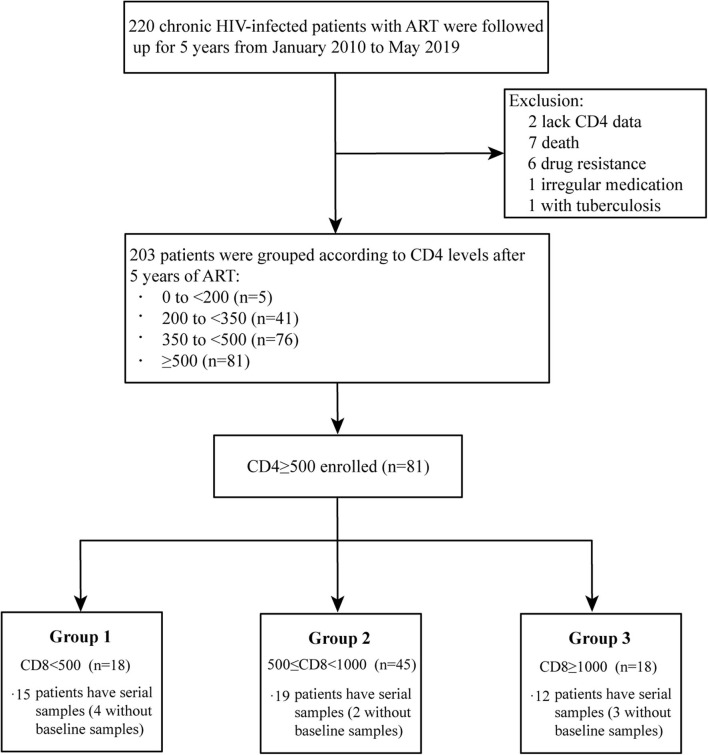
Flow chart of participants enrolled in this study.